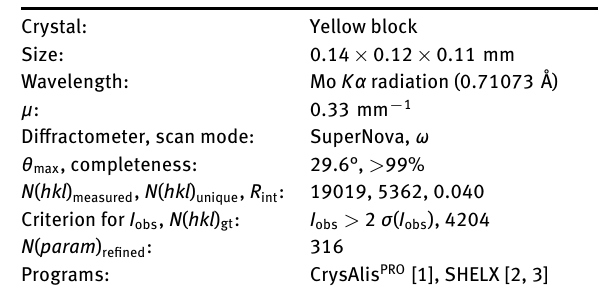
Table 1: Data collection and